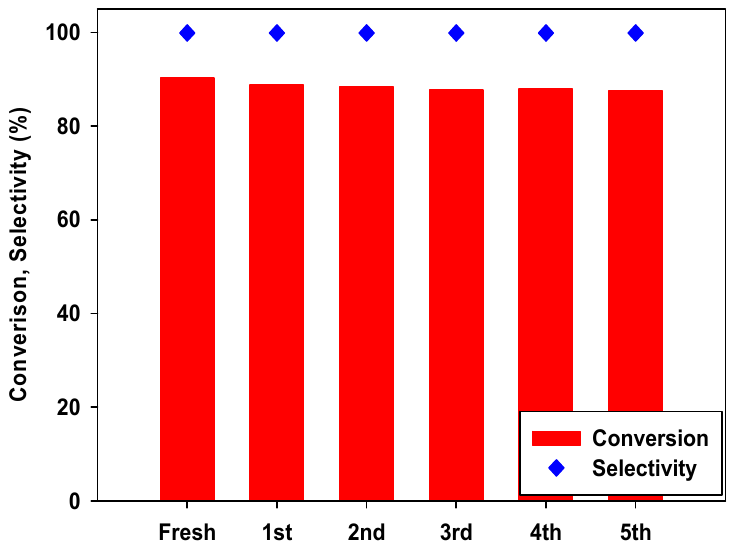
Figure 9. Reusability test of CPM-200-In/Mg catalyst. (epichlorohydrin (ECH) 38.3 mmol, catalyst 0.6 mol%, 80 °C, 6 h, 1.2 MPa).